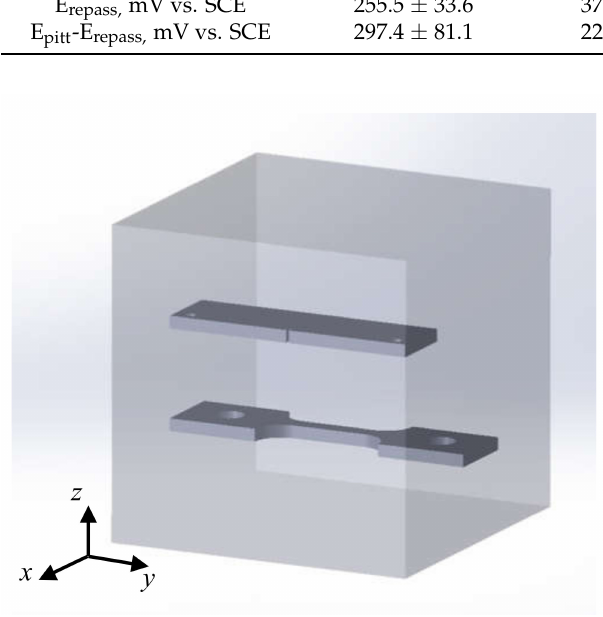
Figure 2. Cyclic polarization curves for multiple orientations of LPBF samples on different coordi- nate surfaces; orange arrows represent the direction of the hysteresis loop. Table 3. Critical corrosion characteristics including repassivation potential E repass , and the difference between the pitting potential and repassivation potential, E pitt -E repass, extracted from the CP scan. Conventional LPBF-XY